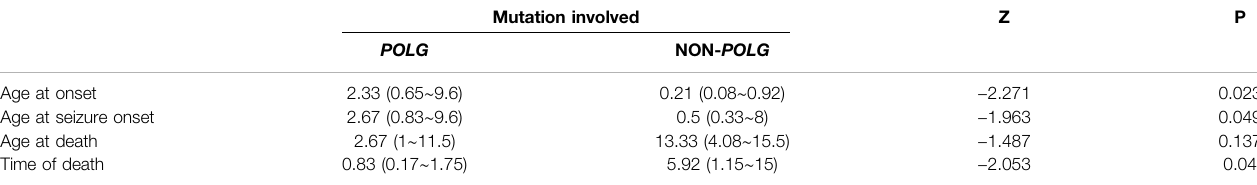
TABLE 2 | Comparison of mutations and clinical features of 29 cases with Alpers ’ syndrome by nonparametric test. Mutation involved